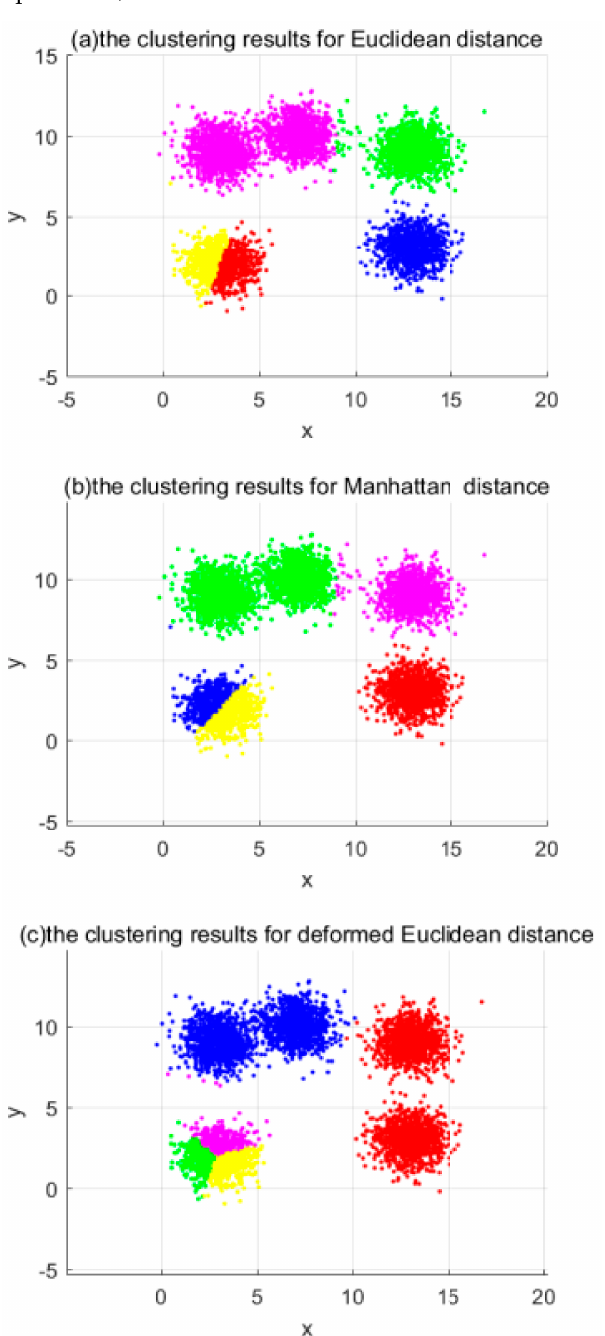
Figure 5. Dataset A: Clustering results with different distance